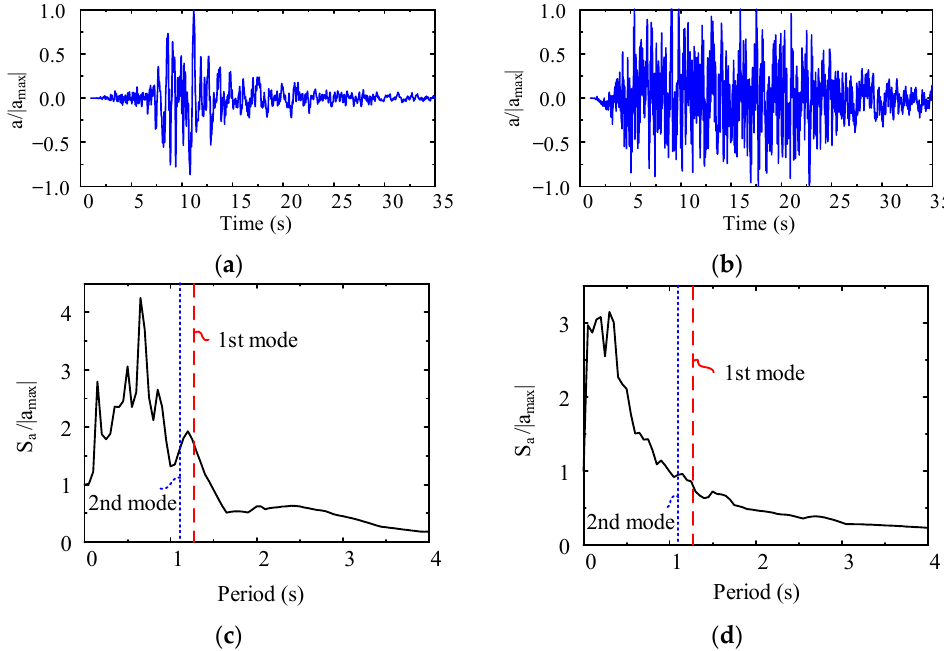
Figure 7. Time–history curves and seismic response spectra: ( a ) time–history curve of seismic wave 1; ( b ) time–history curve of seismic wave 2; ( c ) seismic response spectrum of seismic wave 1; ( d ) seismic response spectrum of seismic wave 2.